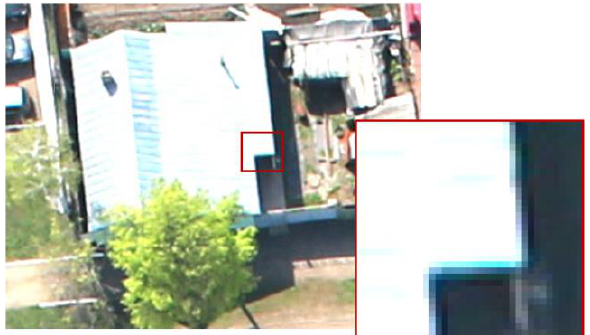
Figure 2. An example of edge transitions in a sharp image (left) and in a blurry image (right) If an image has areas of illumination, they also have edge transitions, shown in Figure 3. However, such edge transitions are related to artifacts and cannot be used to assess the image’s sharpness.